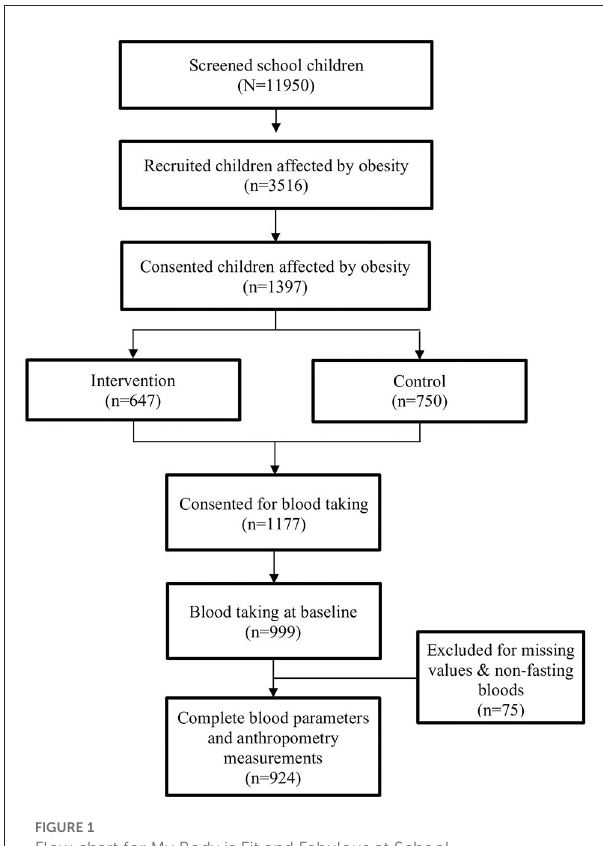
FIGURE1 Flow chart for My Body is Fit and Fabulous at School (MyBFF@school) study at